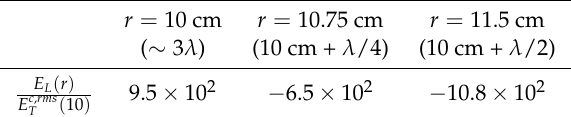
Table 1. Normalized longitudinal field at t = 0 as a function of the distance r . See explanations in